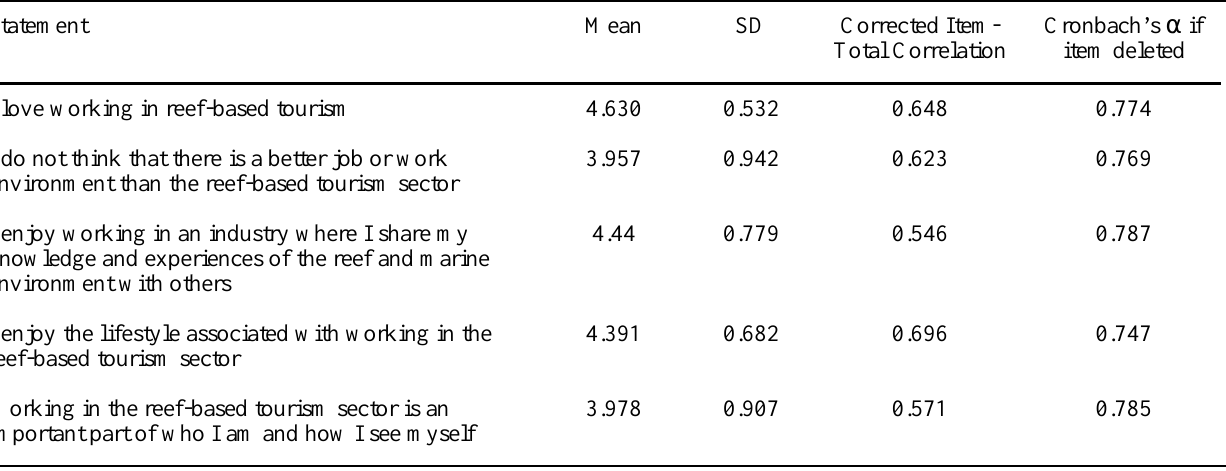
Table 2. Items in the composite scale for lifestyle identity measured on a 5 point Likert scale (1 = strongly disagree/negative, 5 = strongly agree/positive), Cronbach’s a = 0.771; n =